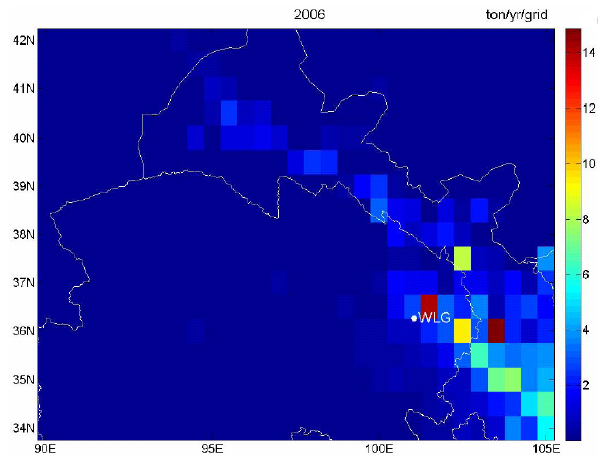
Fig. 9. Total anthropogenic emissions (including biofuels) of CO based on the INTEXB (Intercontinental Chemical Transport Experiment-Phase B) emission inventory for the region around WLG (black dot in the map is location of WLG) (http://www.cgrer. uiowa.edu/EMISSION DATA new/data/intex-b